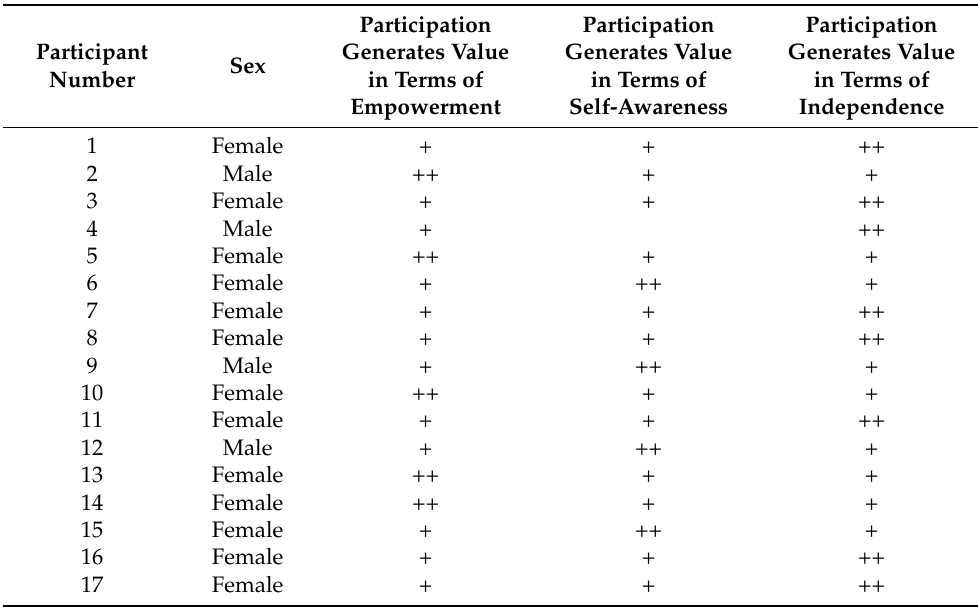
Table 3. The parents’ ways of understanding the value of participation for children within pediatric rehabilitation services. Predominant (++) and non-predominant (+) ways.